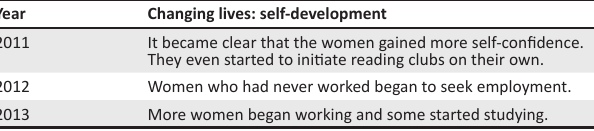
TABLE 6: Themes identified from monthly and yearly reports and field notes: Changing lives: self-development.